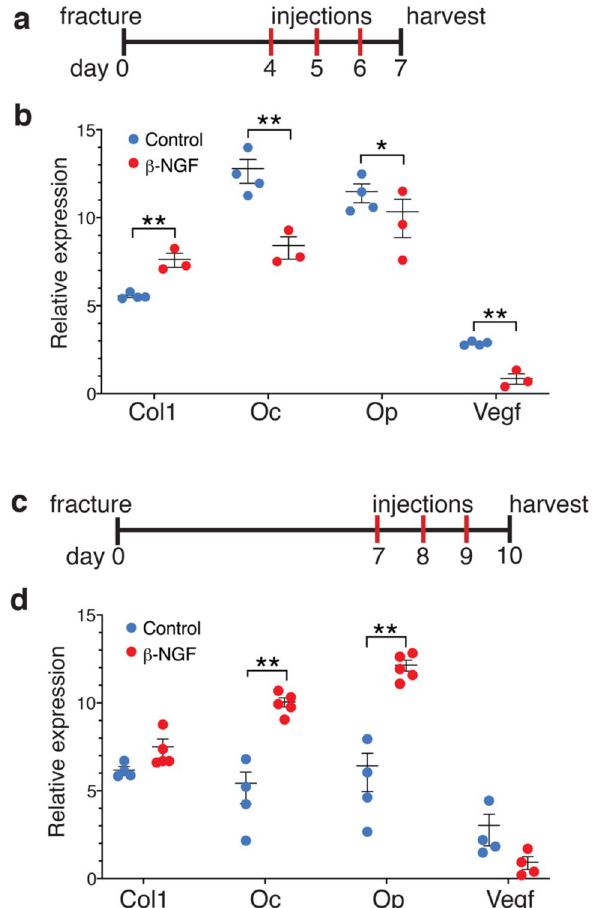
Figure 2. Local β-NGF injections during hypertrophic cartilage phase promotes osteogenic marker expression. ( a ) Timeline schematic of fracture and three daily injections 0.5 μg β-NGF vs control (media injected) starting at 4 days post-fracture. ( b ) Expression levels of selected osteogenic and angiogenic markers from whole-callus tissue harvested 24 h after final injection. ( c ) Timeline of fracture and three daily injections 0.5 μg β-NGF vs control) starting at 7 days post-fracture. ( d ) Expression levels of osteogenic and angiogenic markers from whole- callus tissue harvested 24 h after final injection. All expression levels are relative to Gapdh ; calculated by 2 -ΔCT . Error bars represent SEM. *p < 0.05, **p < 0.01; determined by 2-tailed t